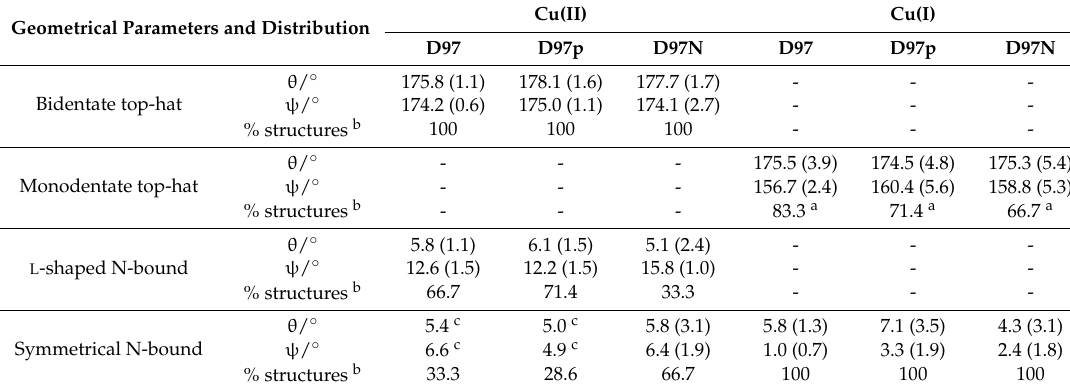
Table 3. Distribution of θ and ψ angles for the optimised